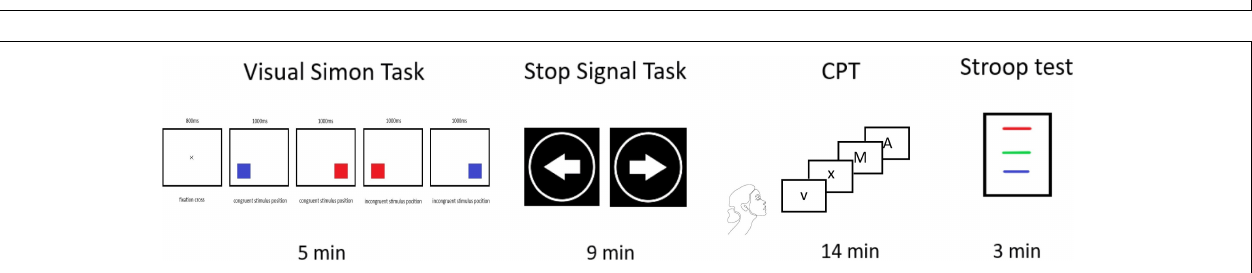
FIGURE 2 | The electrode placement used in the individualized and non-individualized HD θ -tACS protocols. (Top) The individualized placement of electrodes for HD θ -tACS of the ACC targeted through the mPFC-ACC was selected on the basis of a reciprocity-optimized selection of current injection electrodes. Six anode-cathodes (red electrodes) and 10 cathode-anodes (blue electrodes) are shown. Note that to select the optimal electrode arrangement and current injection electrode, the individualized flux pattern with the highest specificity of current flow for a given target region (mPFC-ACC) on the cortical surface model was used. This is an example montage. (Bottom) Non-individualized placement of electrodes in the FCz and Pz areas (Vosskuhl et al., 2015; Fusco et al., 2018) adapted for the HCGSN 100 using the 10-channel mount with five anode-cathodes (red electrodes) in the FCz area and five cathode-anodes (blue electrodes) in the Pz area for a MFC and medial parietal cortex electrode layout. (Left) anterior view without marking the current density; (middle left) sagittal view; (middle right) anterior view; and (right) view from above, with cortex coloring representing the calculated current density on the cortical surface from 0.0 µ A/mm 2 (black) to 1.0 µ A/mm 2 (yellow).